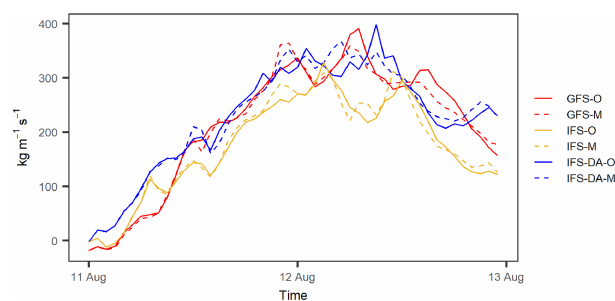
Figure 9. Time evolution from 00:00UTC on 11 August 2015 to 00:00UTC on 13 August 2015 of the vertically integrated water vapour flux (kgm − 1 s − 1 ) crossing section A–A’, shown in Fig.